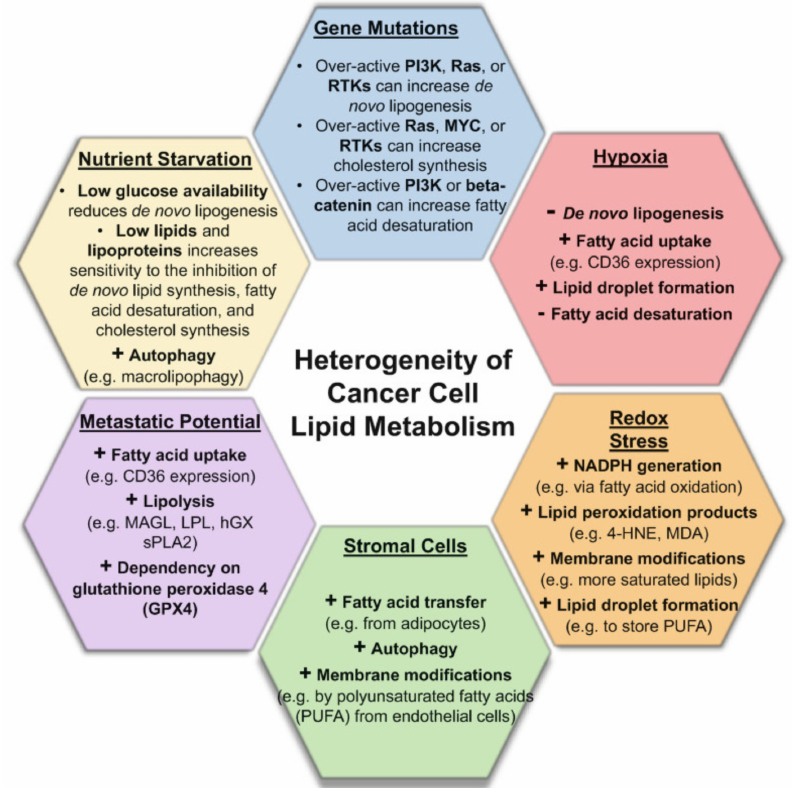
Figure 2. Heterogeneity of lipid metabolism in cancer. Overview of multiple factors that can influence lipid metabolism in cells, creating additional molecular heterogeneities that must be captured in ambient MS profiling studies through use of a large, balanced, and heterogenous sample set. These factors can be external (diet) and can arise due to intrinsic biological architecture (stroma), mutations, and the tumor microenvironment (hypoxia). Reproduced with permission from